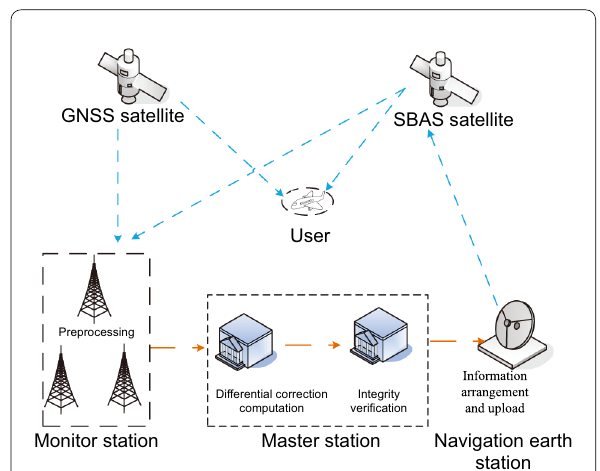
Fig. 1 Satellite integrity monitoring system for SBAS (Li et al.,